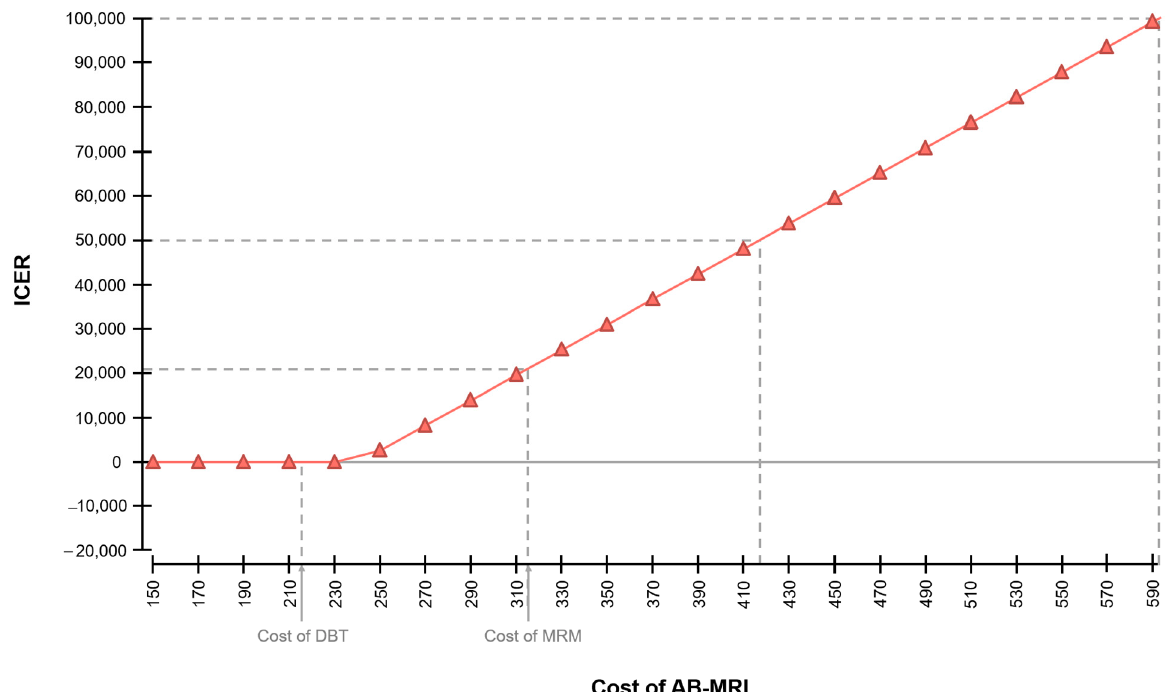
Figure 2. One-way sensitivity analysis for the cost of AB-MRI (US-$) and the corresponding incremental cost-effectiveness Figure 2. One ‐ way sensitivity analysis for the cost of AB ‐ MRI (US ‐ $) and the corresponding incremental cost ‐ effectiveness ratio (ICER in US-$ per QALY gained) compared to DBT. Screening with AB-MRI becomes cost-saving when the cost per ratio (ICER in US ‐ $ per QALY gained) compared to DBT. Screening with AB ‐ MRI becomes cost ‐ saving when the cost per examination of AB-MRI is reduced below $240.79. examination of AB ‐ MRI is reduced below $240.79.